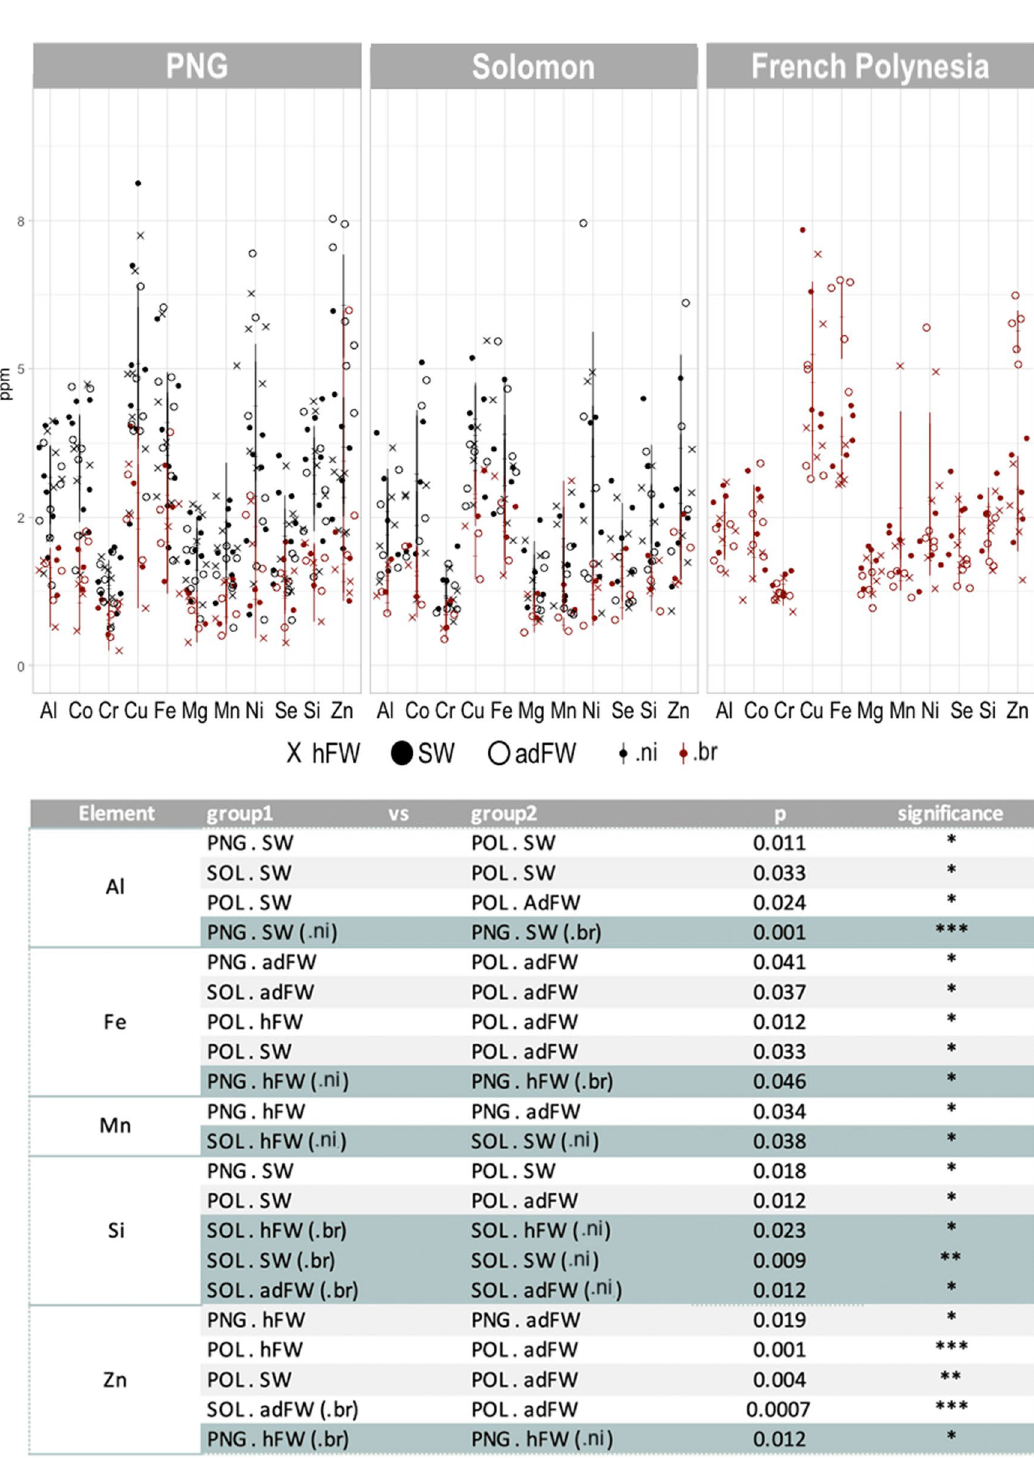
Figure 4. Environmental discrimination fingerprints in the otolith. Trace element (ppm) variations in the otolith zones corresponding to the ’hatching freshwater ’, ’ sea water ’ and ’ adult freshwater ’ conditions (respectively hFW, SW and adFW) and split into the geographic region to which the samples belong. At the bottom are provided the corresponding statistics performed using non-parametric pairwise then post-hoc tests. Argon stability was checked across the samples to ensure robustness and reliability of the data (Supplementary Figure 1). (.ni): Microphis nicoleae ; (.br): Microphis brachyurus ; PNG: Papua New